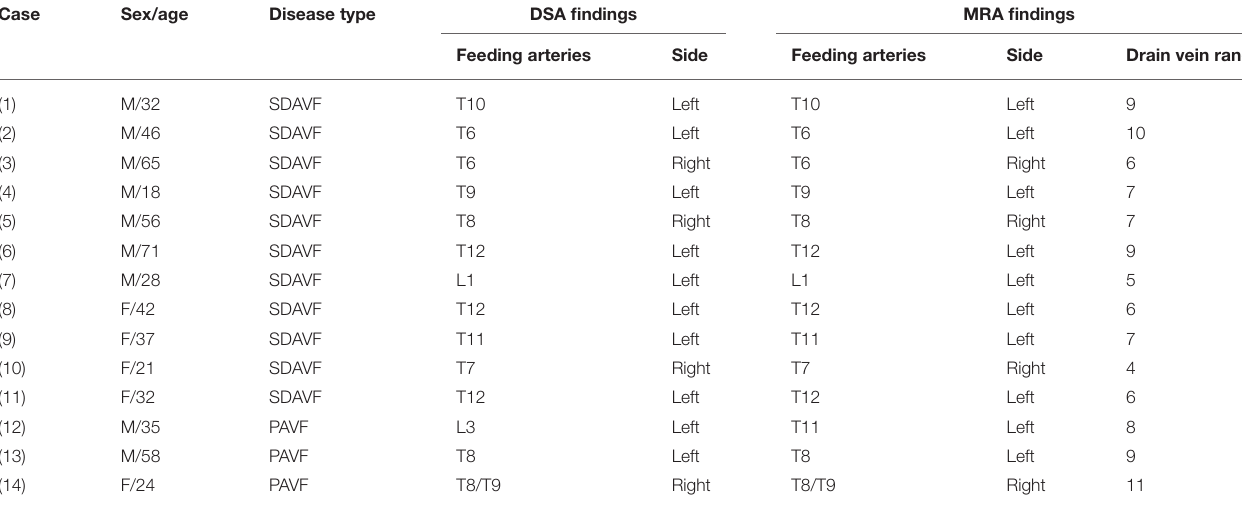
TABLE 4 | Comparison of time-resolved angiography with stochastic trajectories and digital subtraction angiography (DSA) in patients with spinal dural arteriovenous fistula (SDAVF) and perimedullary arteriovenous fistula (PAVF).